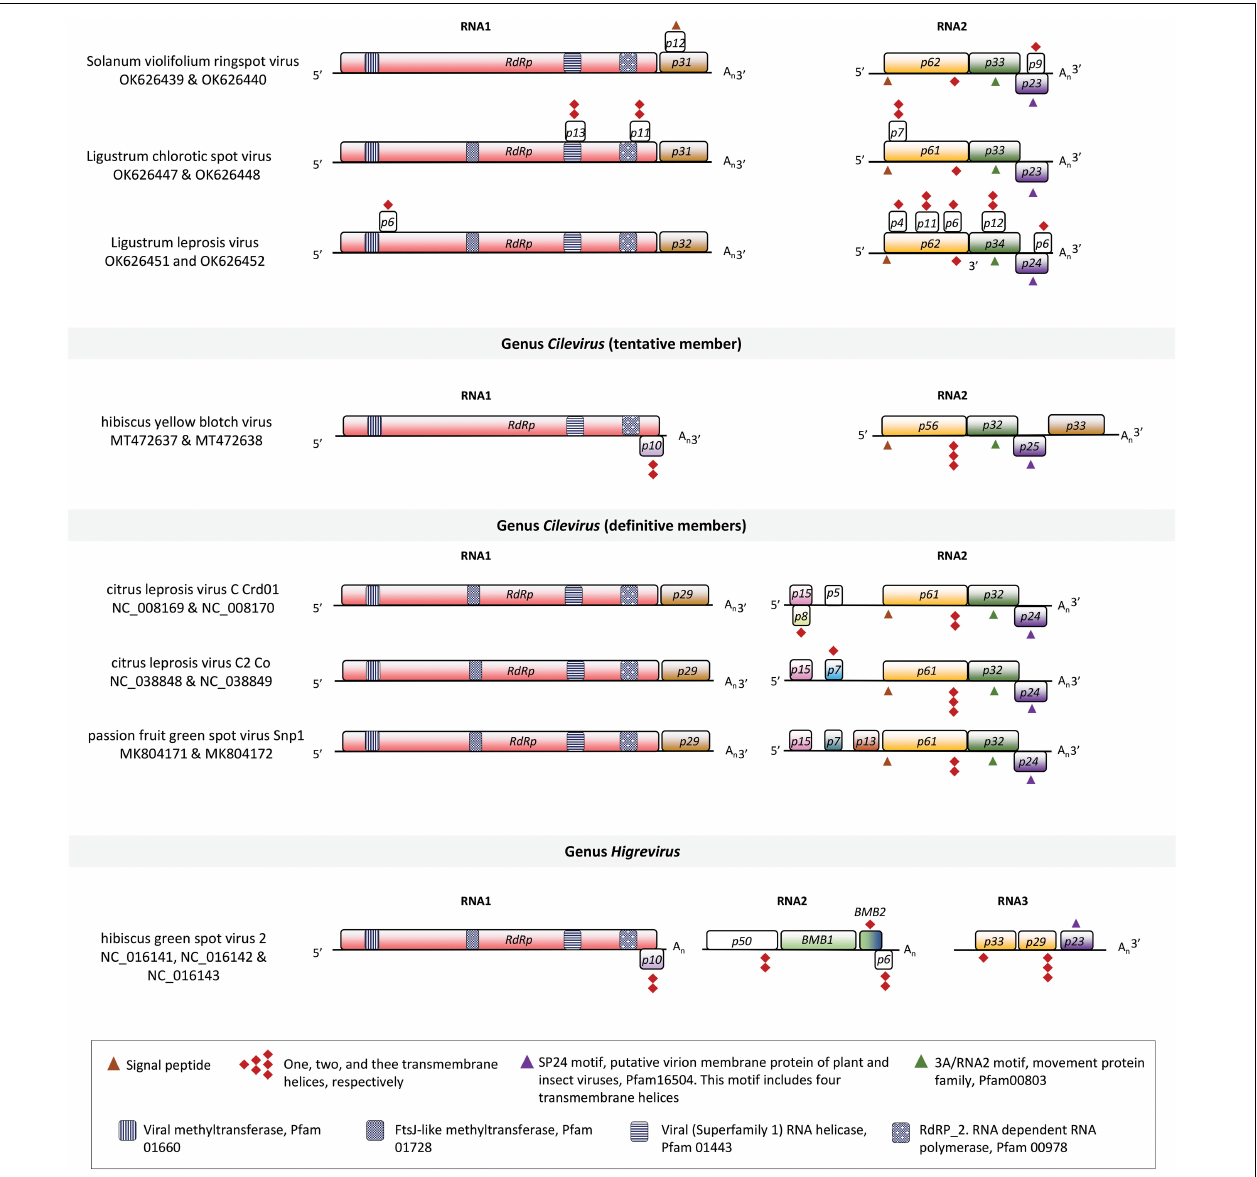
FIGURE 3 | Linear genomic maps of Solanum violifolium ringspot virus, Ligustrum chlorotic spot virus, Ligustrum leprosis virus, and other tentative and definitive members of the family Kitaviridae . Open reading frames (ORFs) are represented by boxes. Colors indicate a putative conserved functional or structural relationship between ORFs from different viruses. In citrus leprosis virus C, genus Cilevirus, RdRp : RNA dependent-RNA polymerase, p29 : putative coat protein, p15 : putative RNA silencing suppressor, p61 : putative glycoprotein, likely a structural protein of the virion, p32 : movement protein, p24 : putative structural protein of the virion. White boxes indicate unknown features. Symbols of black pattern-filled boxes, triangles, and diamonds depict relevant amino acid motifs as described in the legend